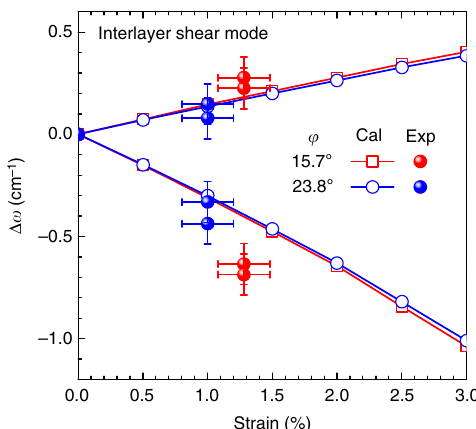
Fig. 2 Splitting of interlayer shear mode under uniaxial strain. Shifts of split interlayer shear modes under uniaxial tensile strain for two different strain directions of φ = 15.7° (red) and 23.8° (blue). Calculation (open circle and square) and experimental ( fi lled symbols) results are compared. For the experimental data, values obtained from the Stokes and anti-Stokes spectra are plotted. Experimental error bars in strain come from the uncertainty in the estimate of the strain using the equation ε = t 0 θ / L 0 as explained in Methods. The error bars in Δ ω are de fi ned by the standard deviation of experimental